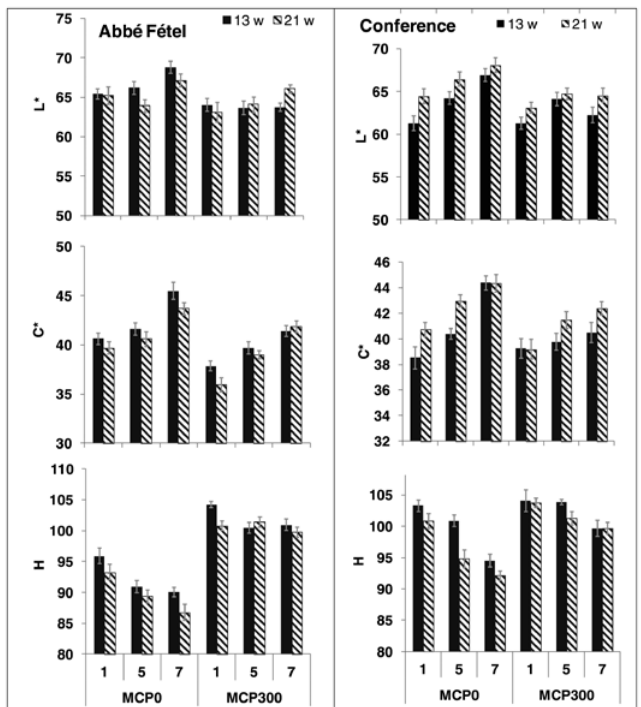
Fig. 5 - Lightness (L*), chroma (C*) and hue angle (degree) of control (MCP0) and 1-MCP treated (MCP300) ‘Abbé Fétel’ and ‘Con- ference’ pears after 1, 5 and 7 days of shelf life at 20°C after 13 and 21 weeks of storage. Bars refer to standard error of the mean. Results of ANOVA analysis are reported in Table